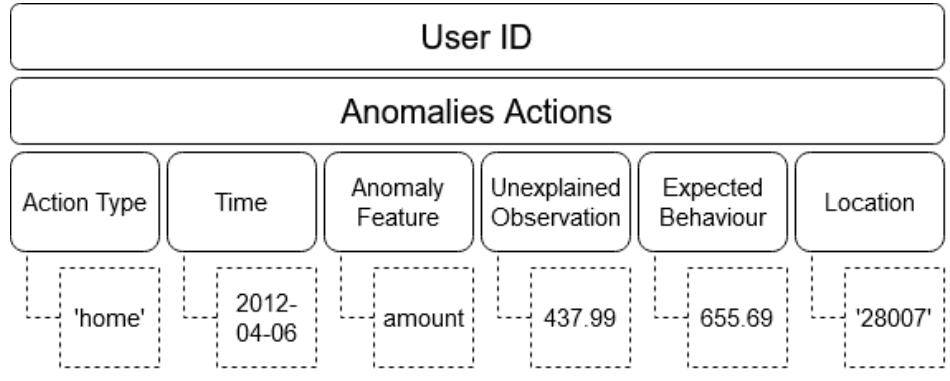
Figure 3. Anomaly